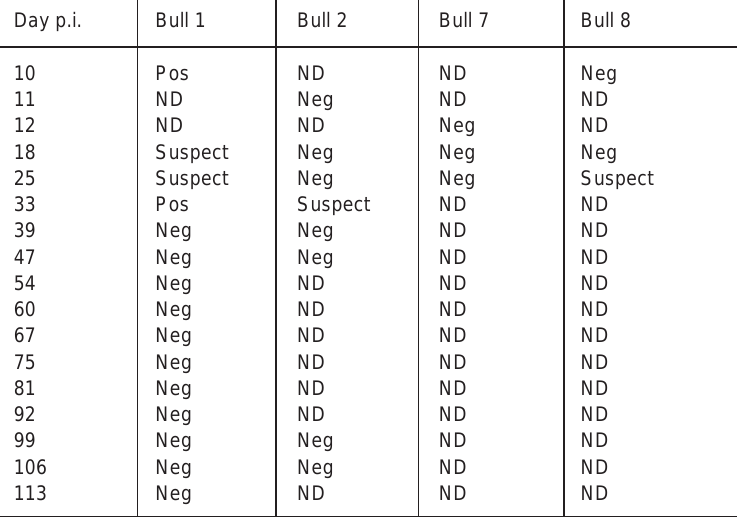
TABLE 2 Transmission electron microscopy results of the skin biopsies of the bulls Day p.i.